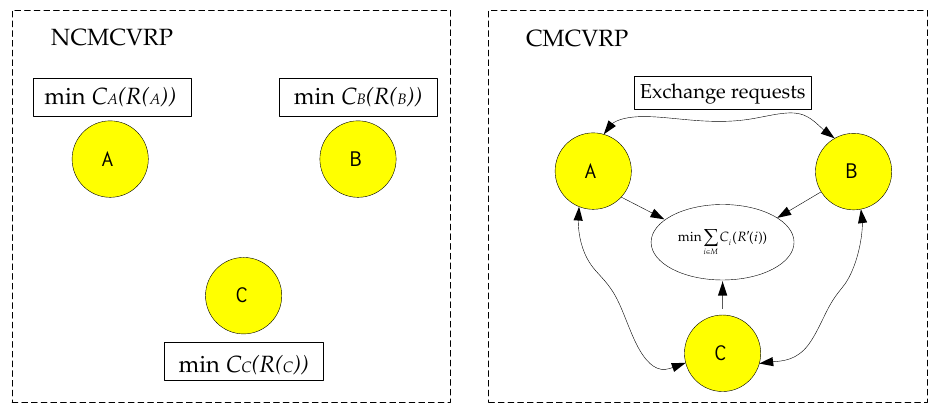
Figure 1. Comparison between the NCMCVRP and the CMCVRP.